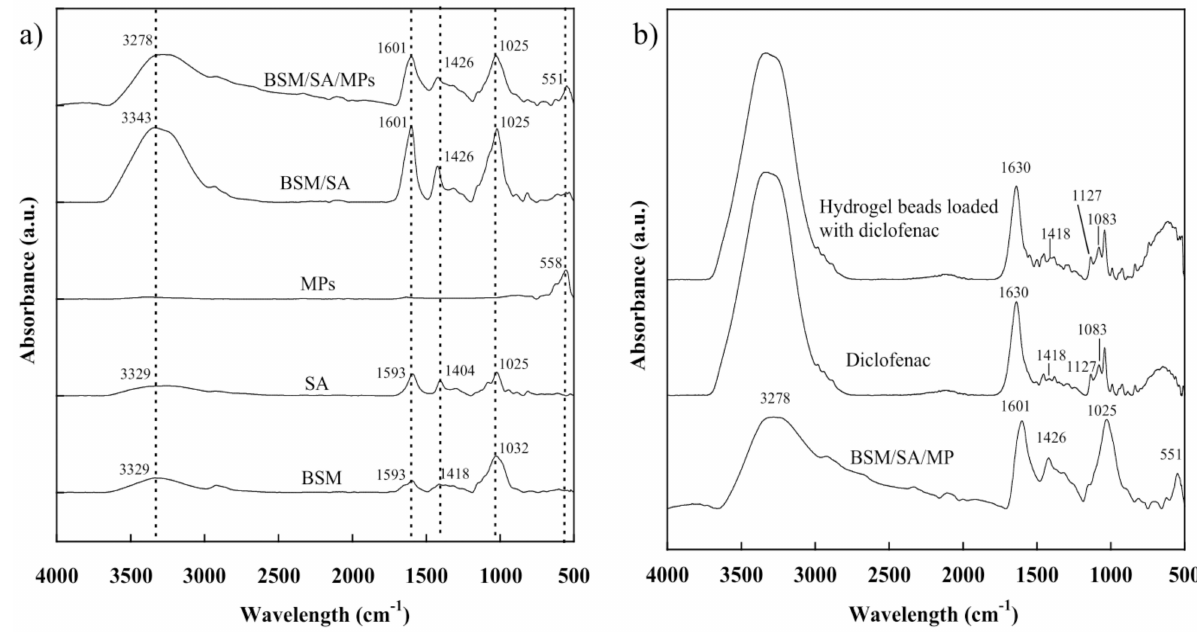
Figure 2. FTIR spectra of ( a ) chemical components and the BSM/SA/MPs hydrogel and ( b ) hydrogel beads loaded with